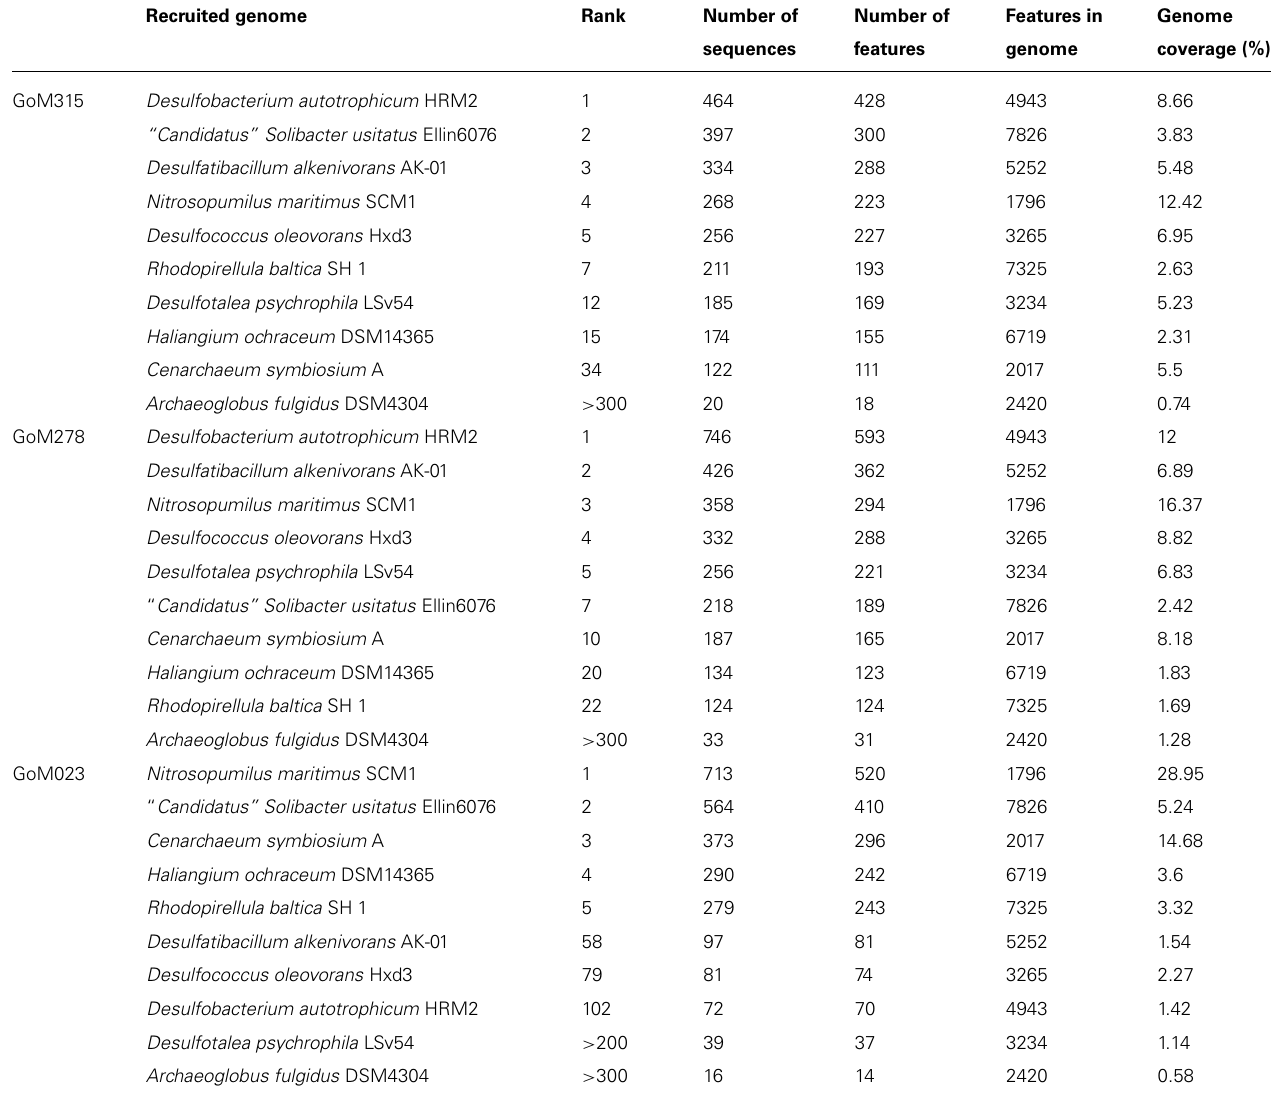
Table 2 |Top ranked recruitment results for each of the GoM deep-sea sediment metagenomic libraries. Recruited genome Rank Number of